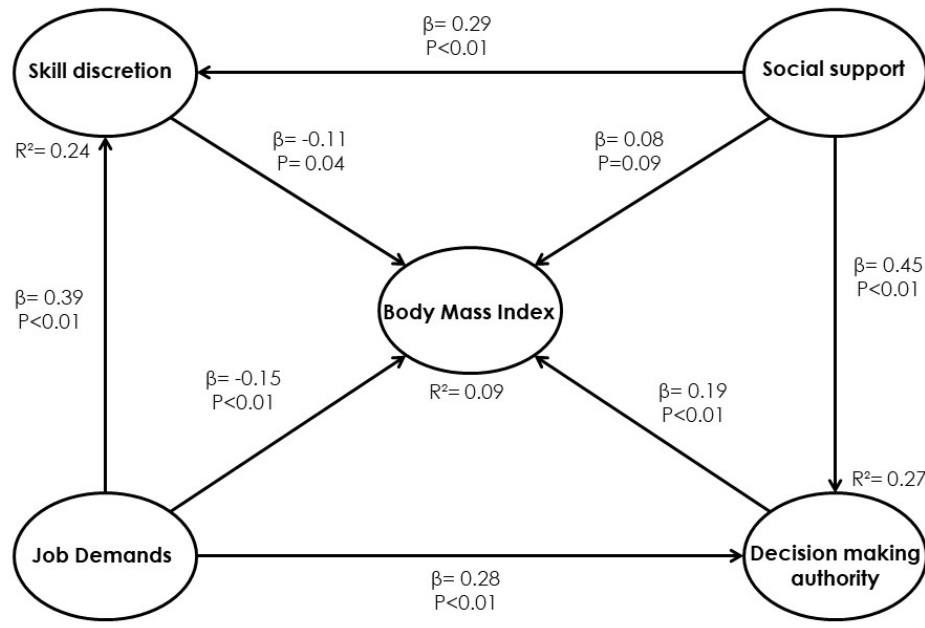
Figure 1. Model 1. Relationship between the job content dimensions and body mass index Figure 1. Model 1 . Relationship between the job content dimensions and body mass index (BMI).